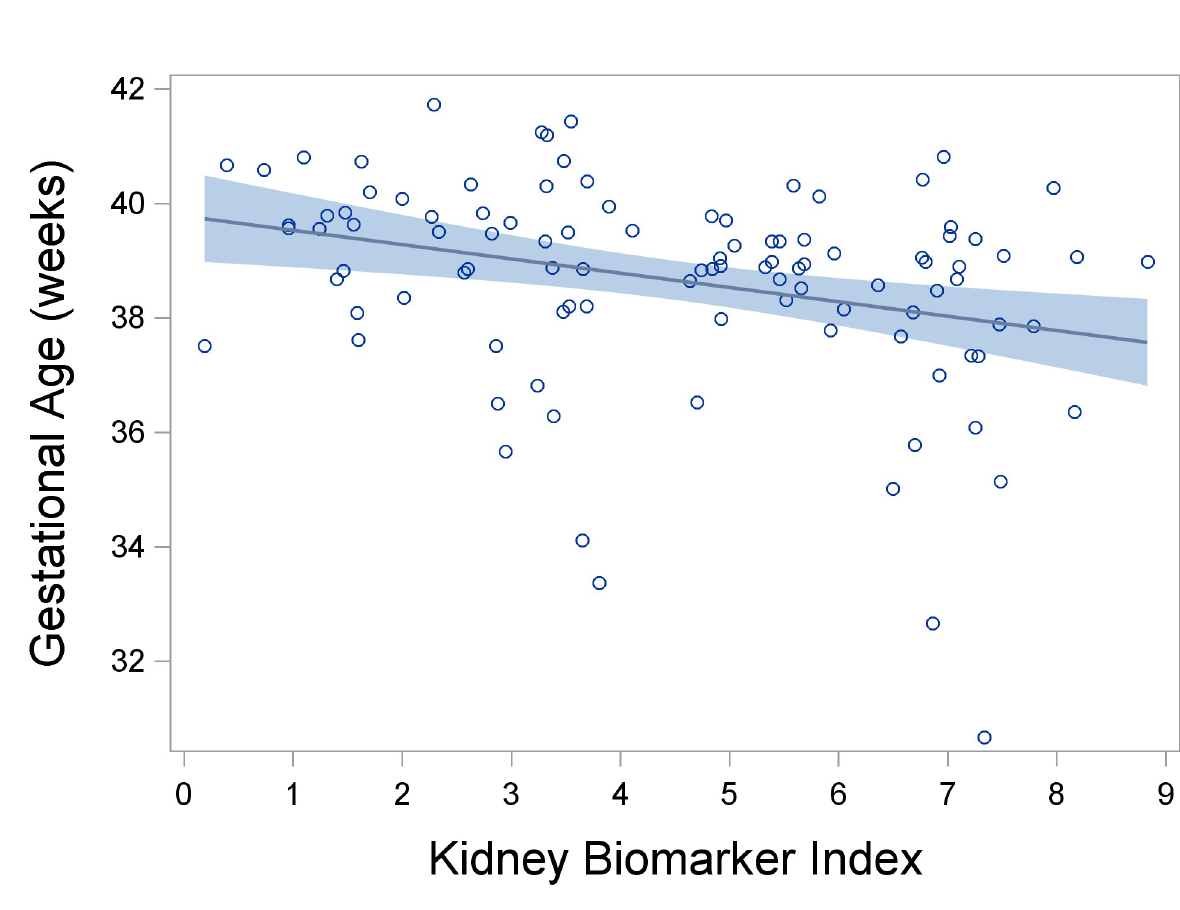
Fig 1. The association between the kidney biomarker index and length of gestation (in weeks) (n = 103). A decile increase in the kidney biomarker index was associated with 0.29-week (2.0-day) shorter gestations ( β = -0.29, 95% CI: -0.45, -0.12). The dark blue line is a linear regression with the 95% confidence interval of the mean shown in lighter blue; the circles represent gestational ages. Plotted gestational age values are residuals that account for child sex, age, BMI, indoor smoking, and urinary creatinine.